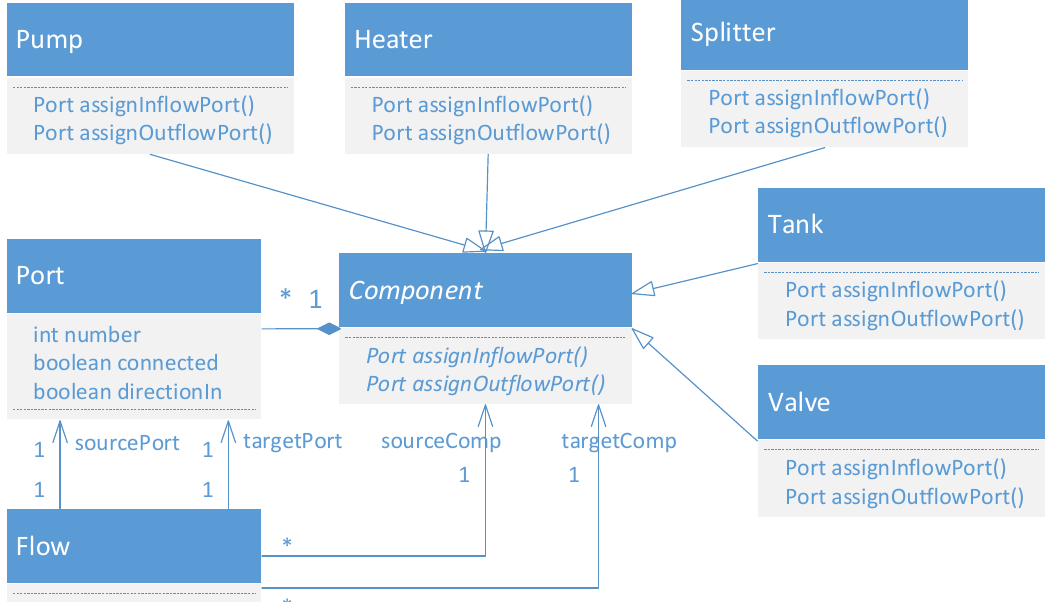
Figure 6. UML class diagram of the steady state model structure.